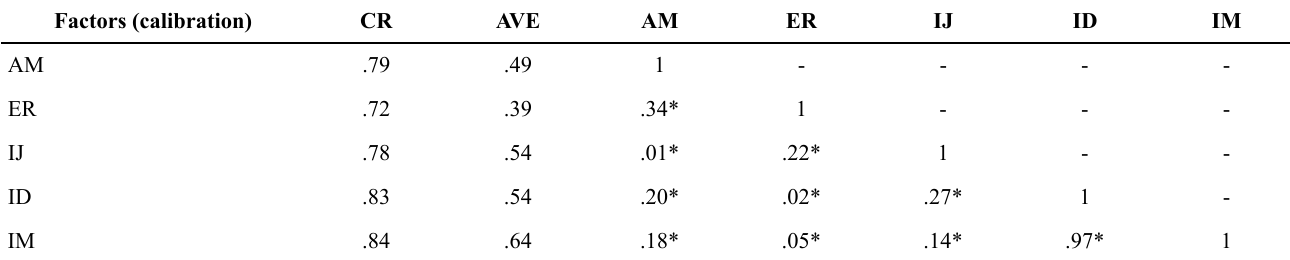
Table 3 Internal reliability, convergent and discriminant validity and average variance extracted – Calibration and Validation samples Factors